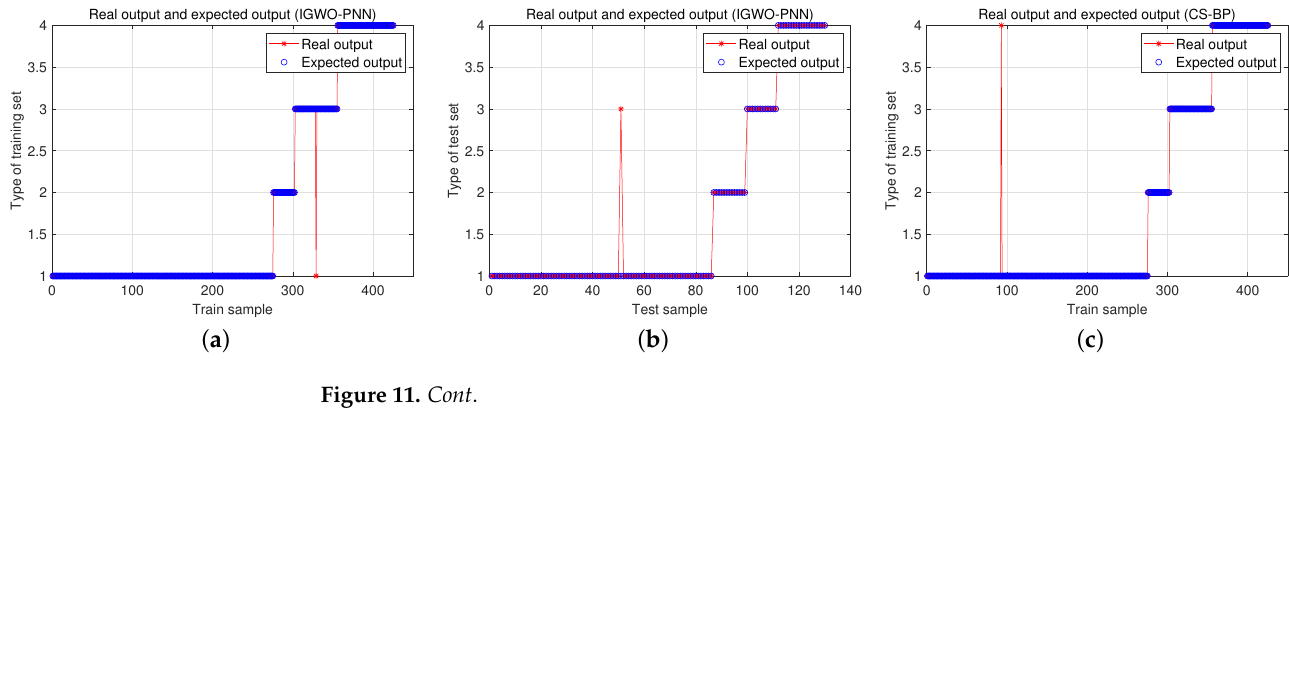
methods, respectively. results of test sample classification for different